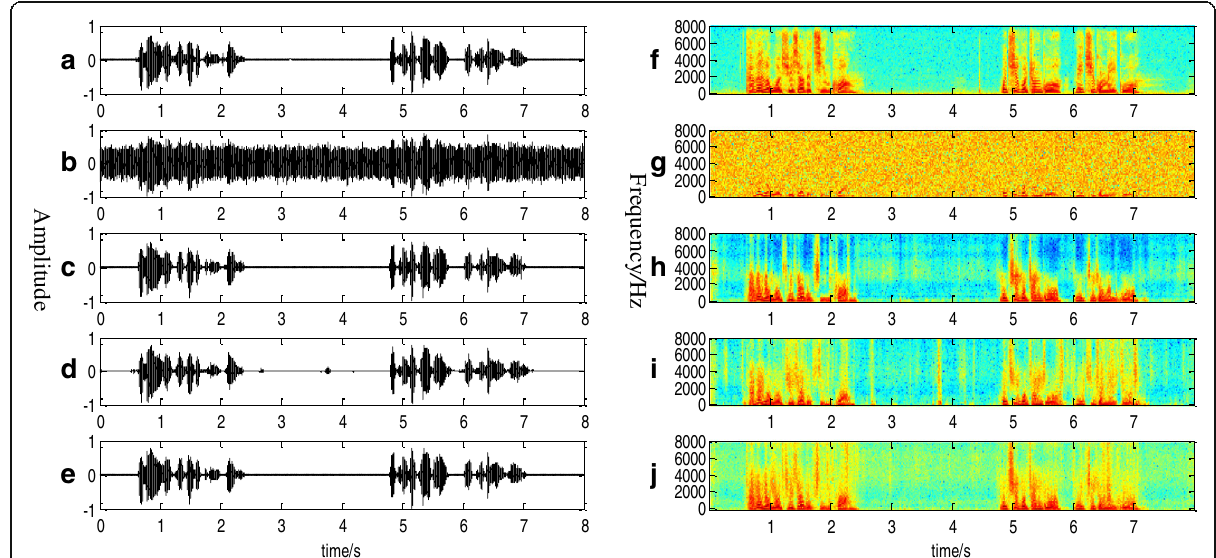
Fig. 5 Speech enhancement effect samples with − 5 dB white noise. a Waveform of clean speech. b Waveform of noisy speech. c Waveform of enhanced with IBM speech. d Waveform of enhanced speech with IRM. e Waveform of enhanced speech with the proposed adaptive mask. f Spectrogram of clean speech. g Spectrogram of noisy speech. h Spectrogram of enhanced speech with IBM. i Spectrogram of enhanced speech with IRM. j Spectrogram of enhanced speech with the proposed adaptive